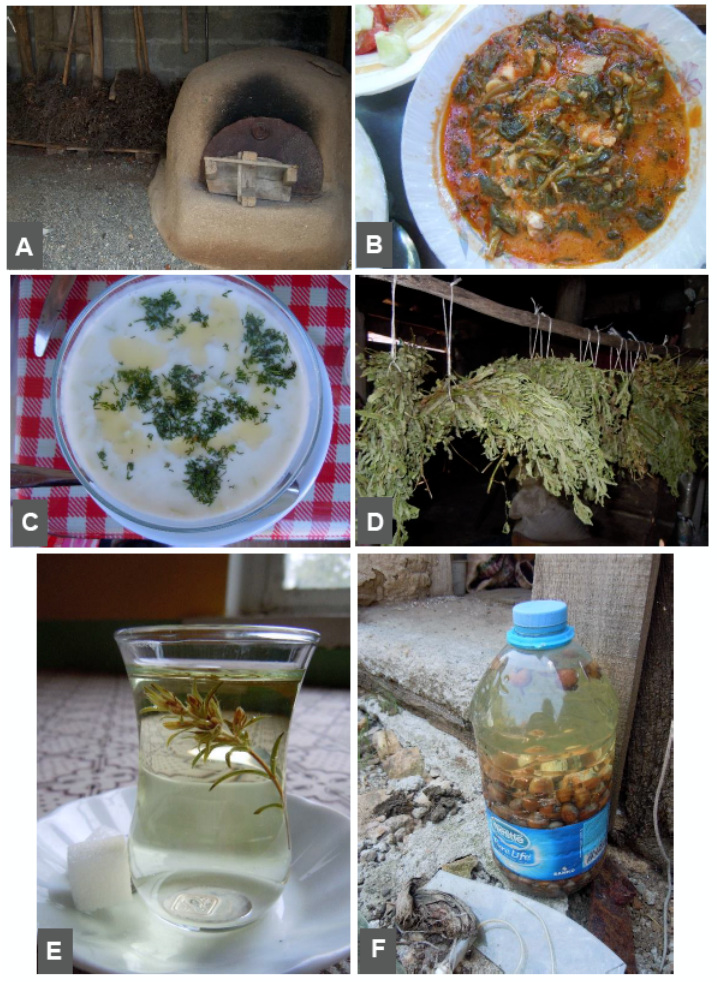
Figure 8 ( A ) Earth oven; ( B ) meal of Portulaca oleracea ; ( C ) Anethum graveolens as a spice in cacık; ( D ) dried Mentha sp.; ( E ) tea made from Origanum sp.; ( F ) pickle made from Pyrus elaeagnifolia